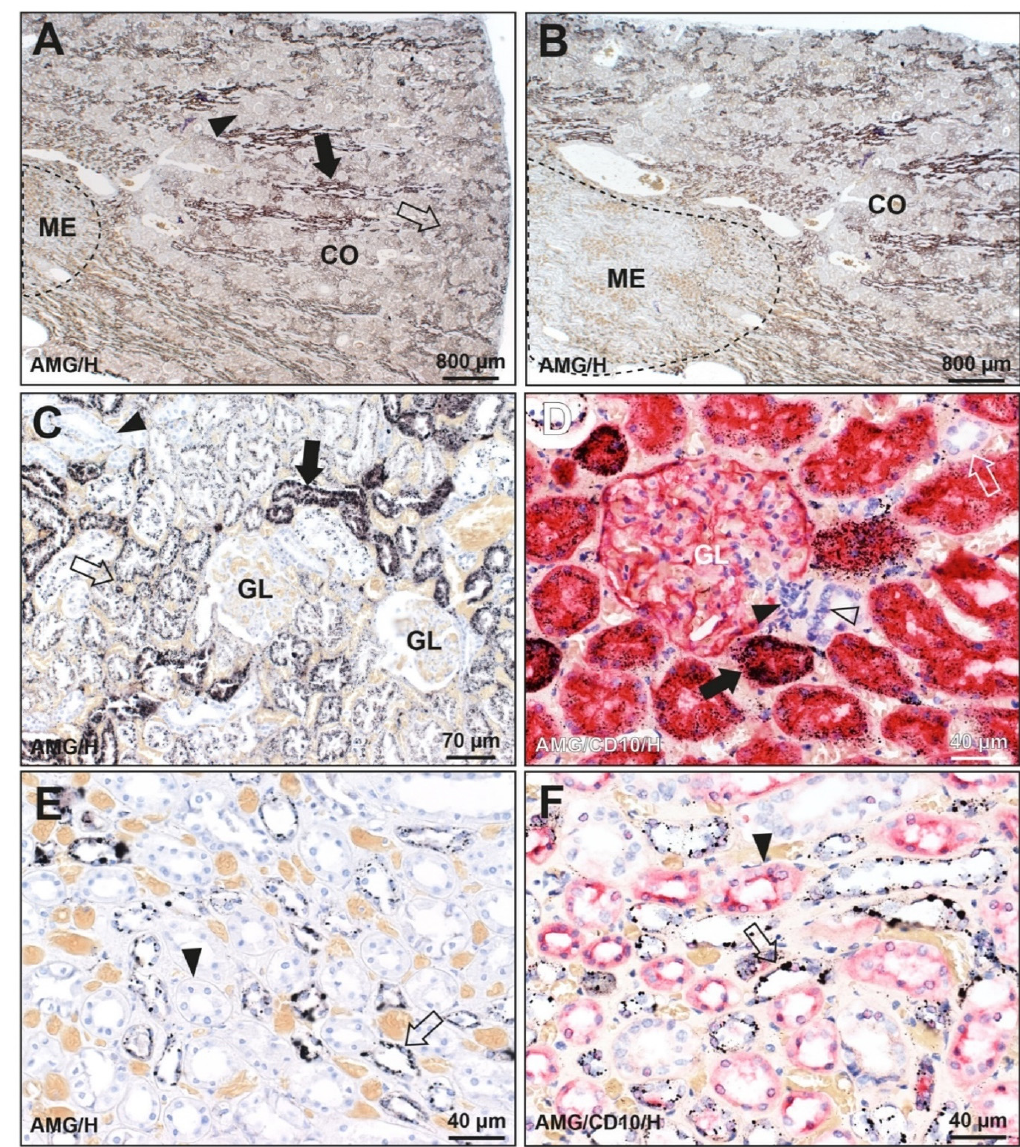
Figure 2. Mercury in the kidney of a man with no known mercury exposure (K44). ( A ) Black-staining mercury is seen in the renal cortex (CO) in cells of the straight (filled arrow) and convoluted (open arrow) proximal tubules, with more mercury in straight tubules. The pale cortical regions (arrowhead) contain glomeruli and distal tubules. The medulla (ME, dashed outline) shows no mercury staining at this magnification. ( B ) A microscopic field to the left of the image in A shows the difference between the plentiful mercury in the renal cortex (CO) and no obvious mercury staining in the medulla (ME, dashed outline). ( C ) Mercury is seen in cells of the proximal straight tubules (filled arrow), with less in the proximal convoluted tubules (open arrow). No mercury is seen in two glomeruli (GL), or in distal tubules (arrowhead). ( D ) Red CD10 immunostaining shows proximal tubule cells containing black mercury grains (filled arrow). No mercury is seen in CD10-negative distal tubules (open arrow), in the macula densa (open arrowhead) or Lacis cells (filled arrowhead) of the juxtaglomerular apparatus or in a glomerulus (GL) whose podocytes stain lightly with CD10. ( E ) Cells in Henle thin loops in the medulla contain black mercury granules of varying size (arrow). Collecting tubules (arrowhead) do not contain mercury. ( F ) Cells in Henle thin loops (not CD10-immunostained) in the medulla contain mercury granules of varying size (arrow). Collecting tubules that stain with CD10 (arrowhead) do not contain mercury. Light brown/yellow staining is from red blood cells in capillaries. AMG/H autometallography/hematoxylin, AMG/CD10/H autometallography/CD10 immunostaining/hematoxylin. K identity number (see Table